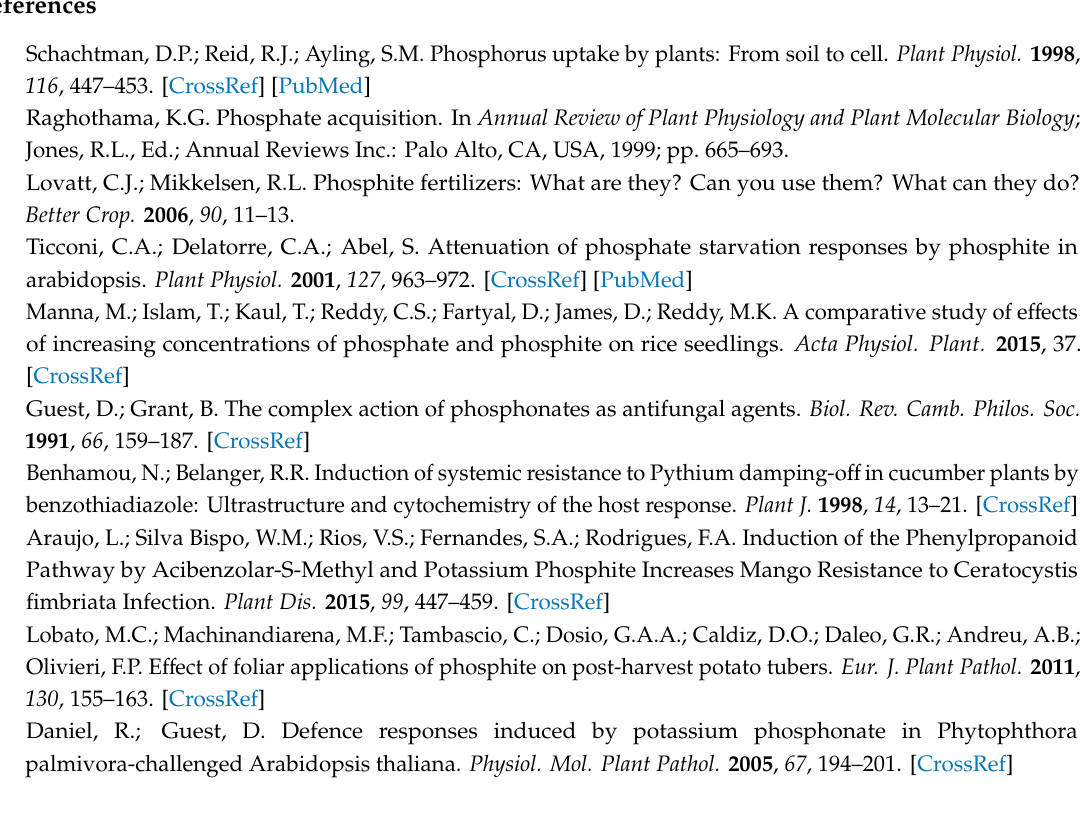
Table S1: Annotations and expression values of the up-regulated di ff erentially expressed genes (DEGs). Table S2: Annotations and expression values of the down-regulated di ff erentially expressed genes (DEGs). Table S3: List of di ff erentially expressed transcription factors. Table S4: The primers used in the qRT-PCR. Figure S1: GO classification of DEGs in C and PHI. Figure S2: qRT-PCR analysis of genes related to PHI treatment. Author